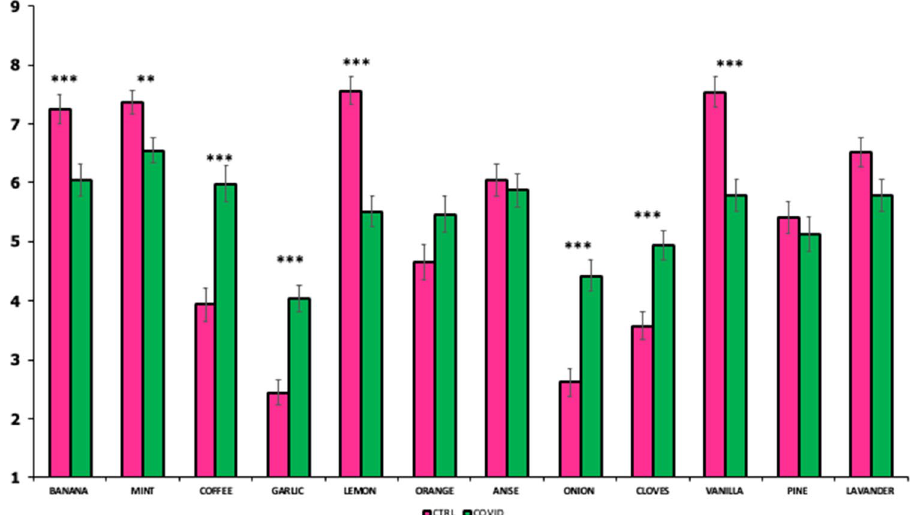
Figure 3. Mean liking ± SEM for the individual odors grouped by controls (CTRL, magenta bars) and cases (COVID, green bars). Statistics according to t- test; ** P < 0.01; *** P <